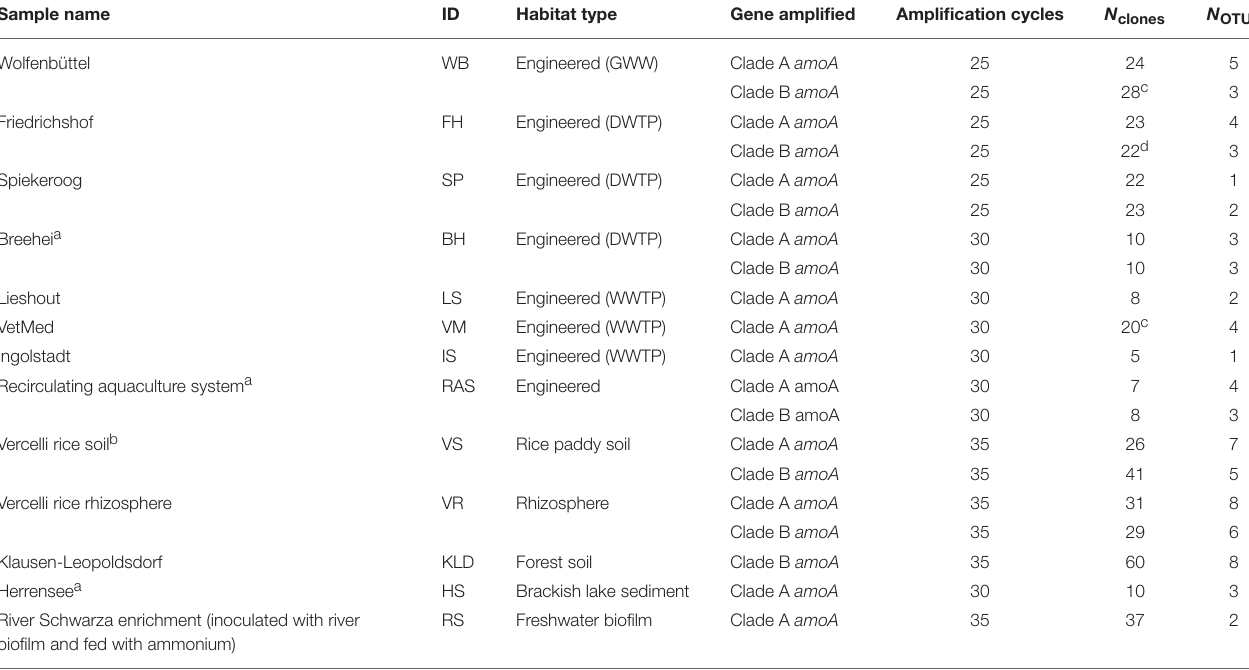
TABLE 2 | Environmental samples analyzed in this study, PCR amplification cycles, and numbers of cloned comammox amoA sequences and OTUs retrieved from each